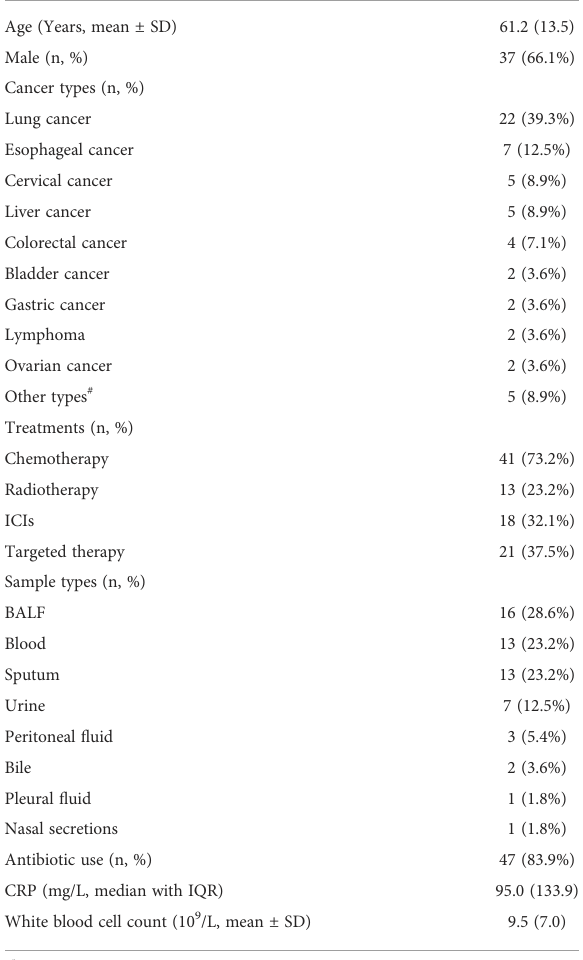
TABLE 1 Demographic and clinical characteristics of 56 cancer patients recruited in this study.